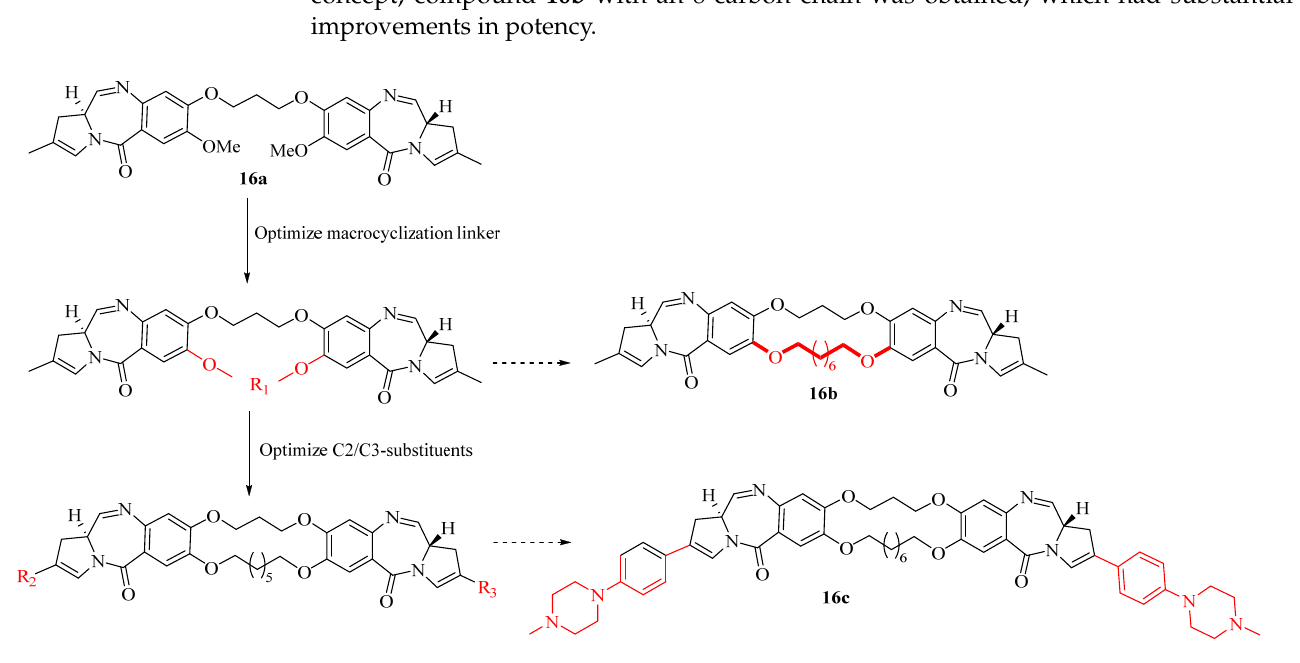
Figure 18. Structural modification of ADCs inhibitors.